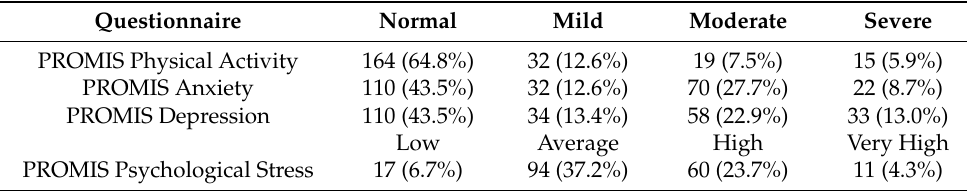
Table 2. PROMIS 1 categorization.